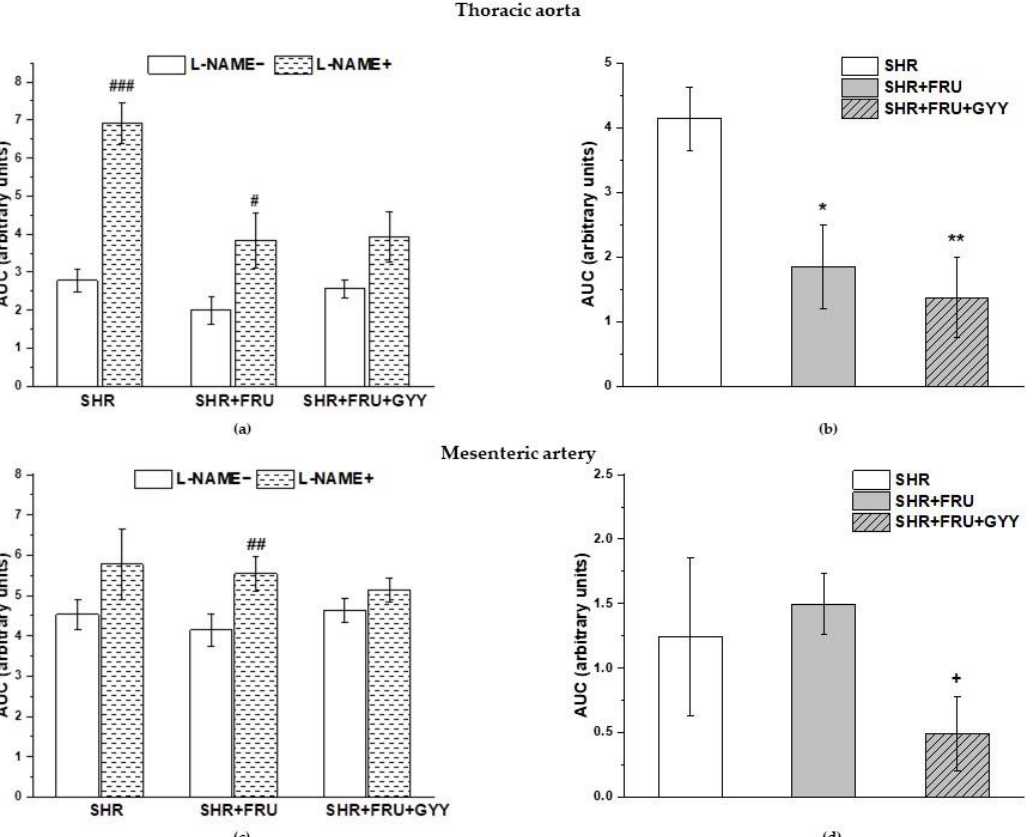
Figure 5. The participation of the NO/NOS system in the contractile responses of thoracic aorta ( a , b ) and mesenteric artery ( c , d ). The AUC calculated before and after the pre-treatment with L-NAME in individual groups ( a , c ). The difference between the AUC before and after L-NAME—comparison among groups ( b , d ). Arteries were isolated from spontaneously hypertensive rats (SHRs), SHRs treated with fructose (SHR+FRU), and SHRs treated with fructose and GYY-4137 (SHR+FRU+GYY). AUC—area under the curve; L-NAME—N G -nitro-L-arginine methylester. The data are presented as the mean ± S.E.M. Statistical analysis was performed by paired t-test or one-way ANOVA. # p < 0.05, ## p < 0.01, and ### p < 0.001 vs. control L-NAME-, * p < 0.05 and ** p < 0.01 vs. SHR, + p < 0.05 vs. SHR+FRU.